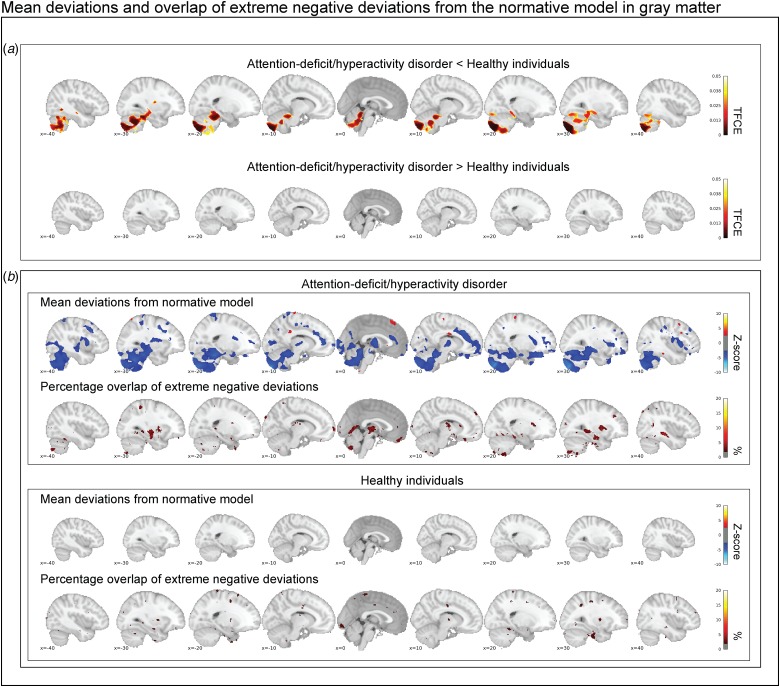
In (a), the contrast between persistent ADHD and healthy individuals is depicted corrected at a false discovery rate of 5%. Cerebellar regions, temporal regions, and the hippocampus deviate significantly in gray matter. In (b), the group-level mean deviations of participants with persistent ADHD and healthy individuals are depicted (|Z| < 2.6) and compared with the overlap maps of extreme negative deviations (Z < −2.6). In summary, while we reproduce prominent group-level differences between healthy individuals and participants with persistent ADHD, we observe that extreme negative deviations are hardly present in more than 2% of the individuals with persistent ADHD in those brain regions.